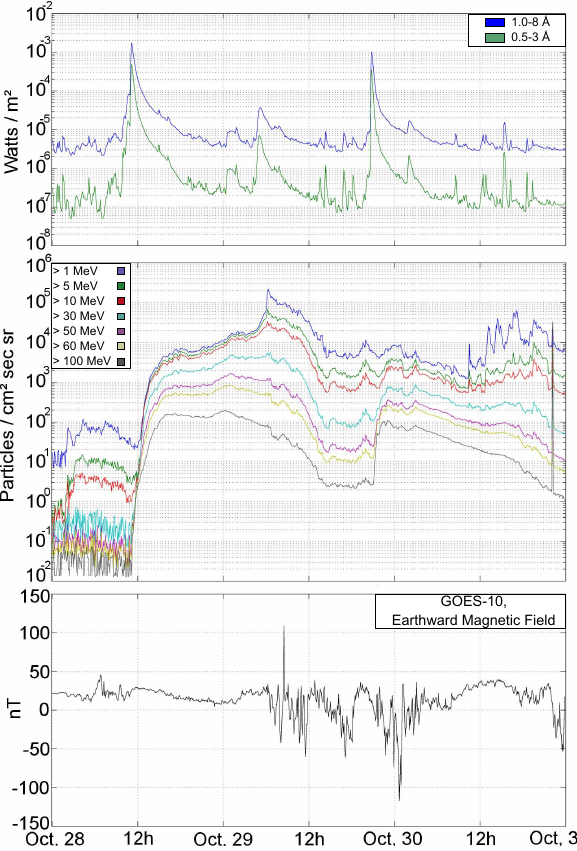
Fig. 6. Satellite measurements by the geostationary GOES-10 S/C during the Halloween period in 2003. The upper panel shows the course of the solar X-rays; in the middle panel the proton fluxes are illustrated. The bottom panel displays data records from the Earth- ward component of the magnetic field. All data records were ob- tained by the National Geophysical Data Center